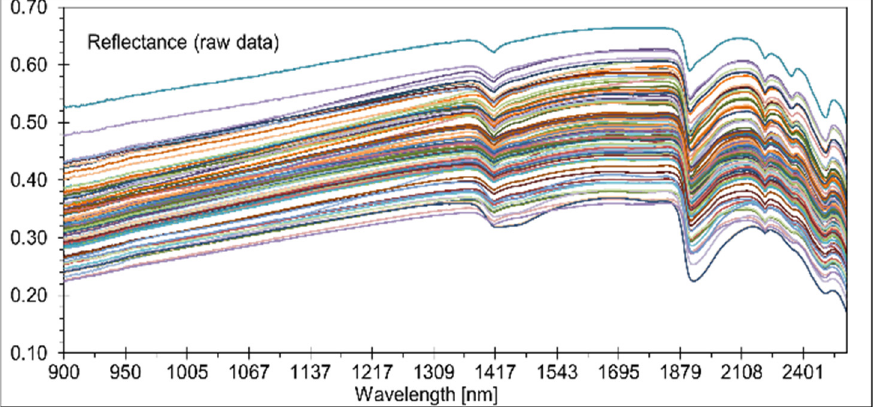
Figure 4. Spectral reflection curves for all soil samples.